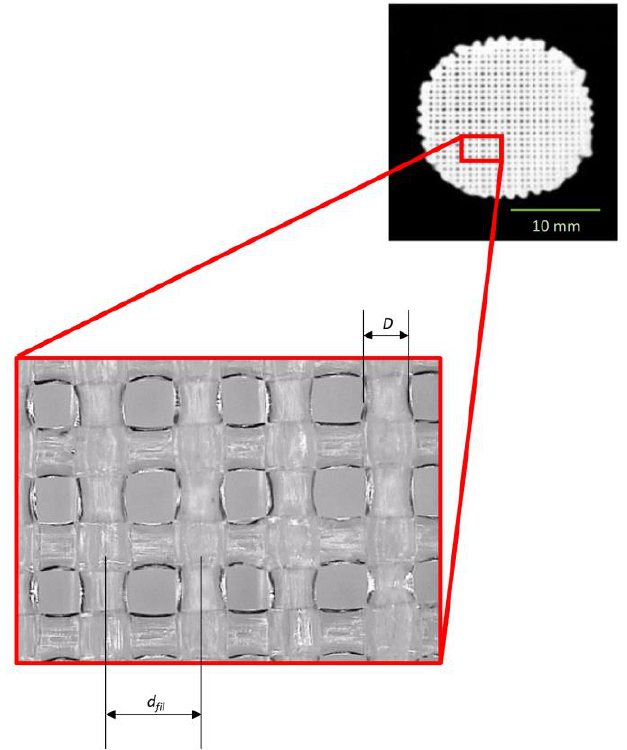
Figure 6. For each scaffold fabricated, the center to center distance between the filaments d fil and the dimension of the diameter D were measured.